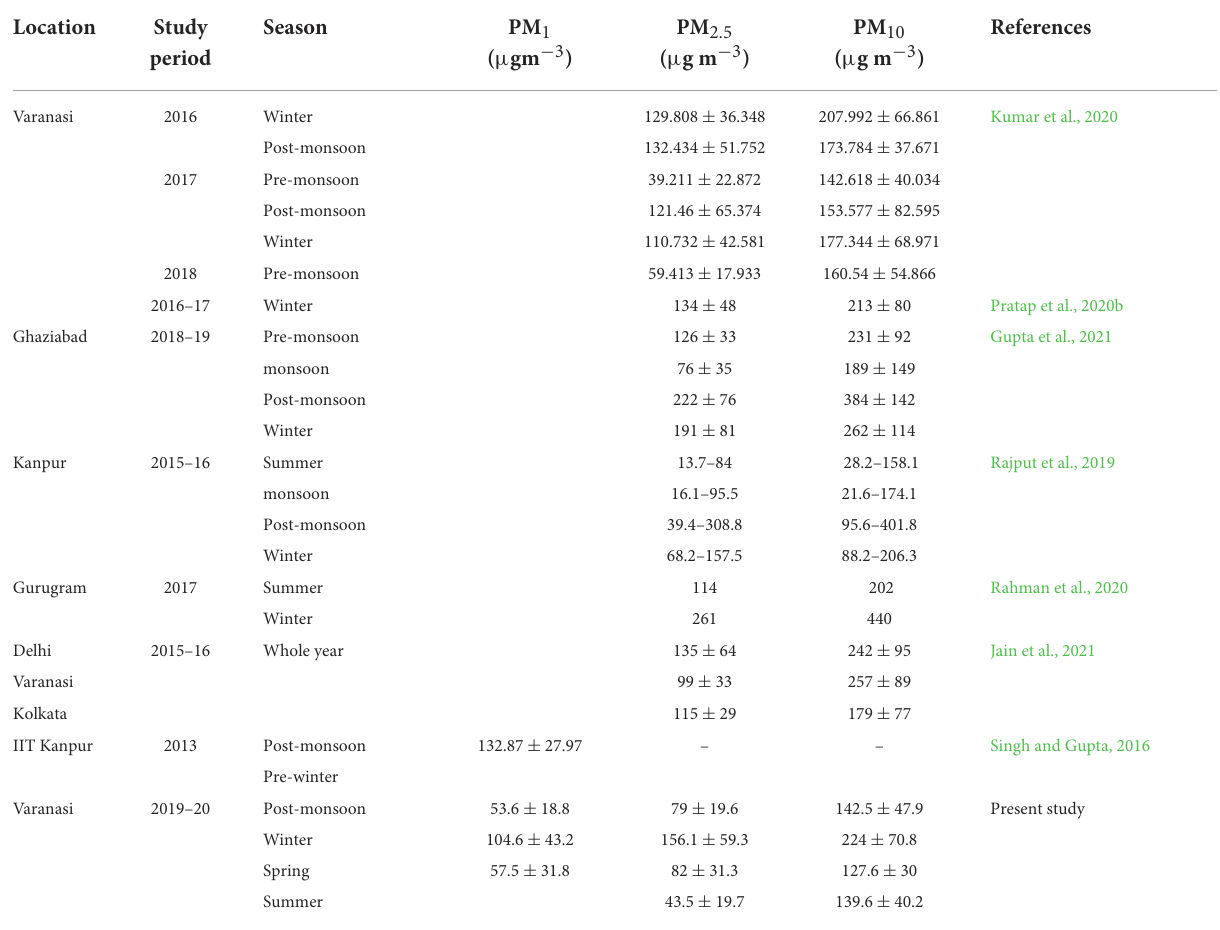
TABLE 1 Previous study of PM 1 , PM 2.5 , and PM 10 samples at different locations in IGP.